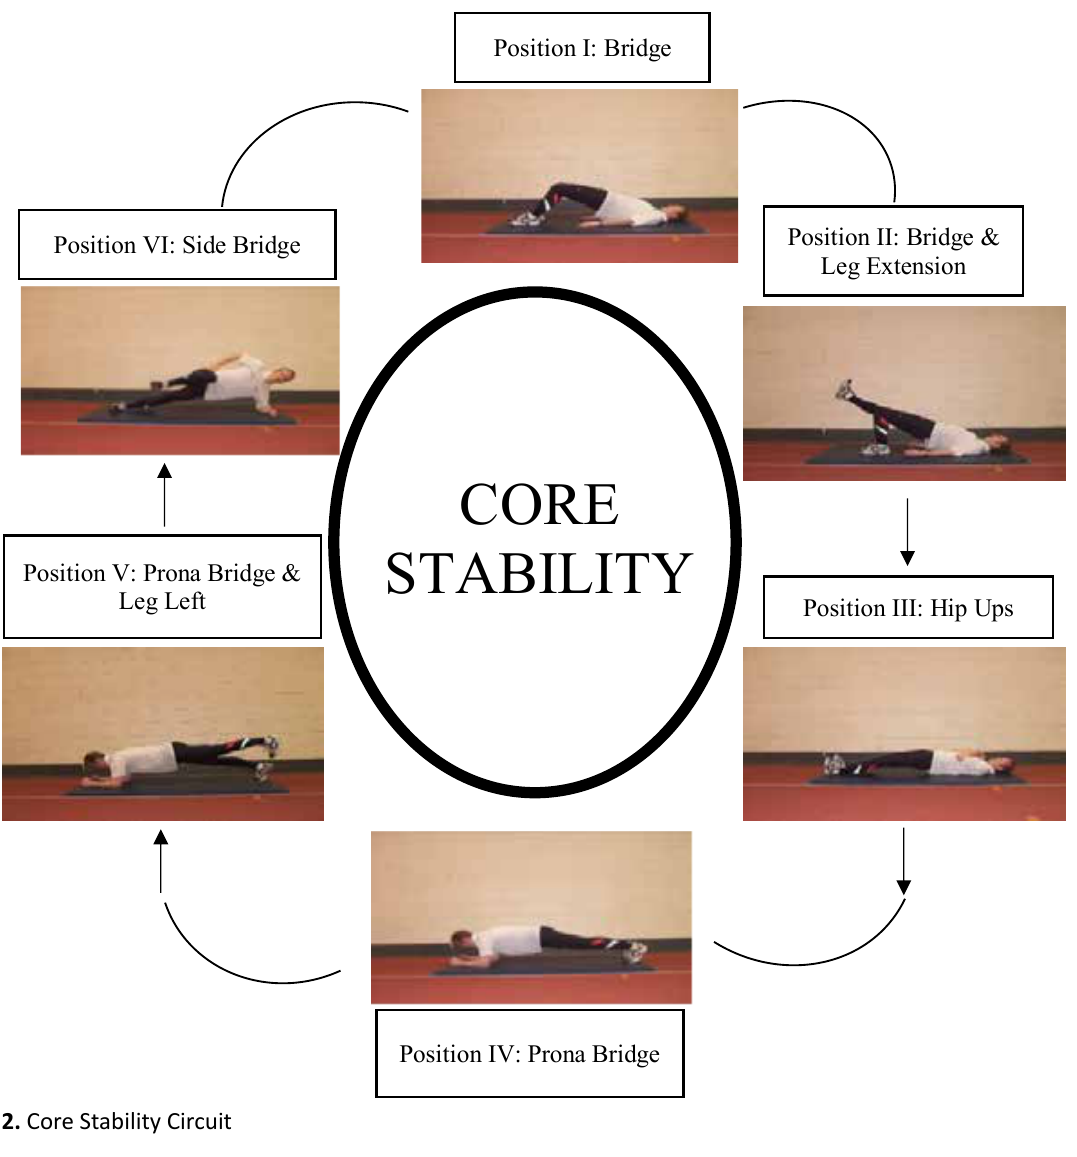
Figure 2. Core Stability Circuit